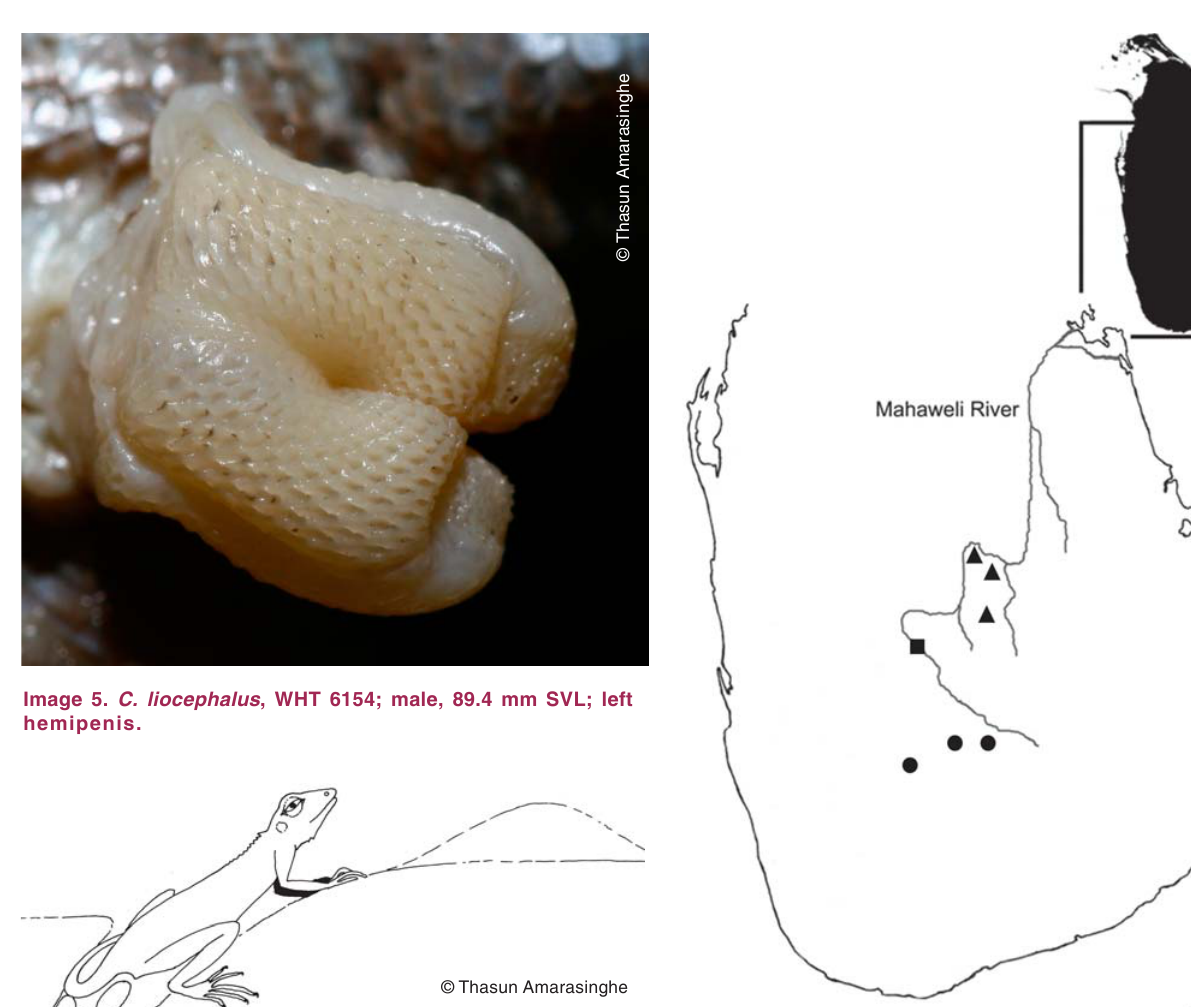
© Thasun Amarasinghe